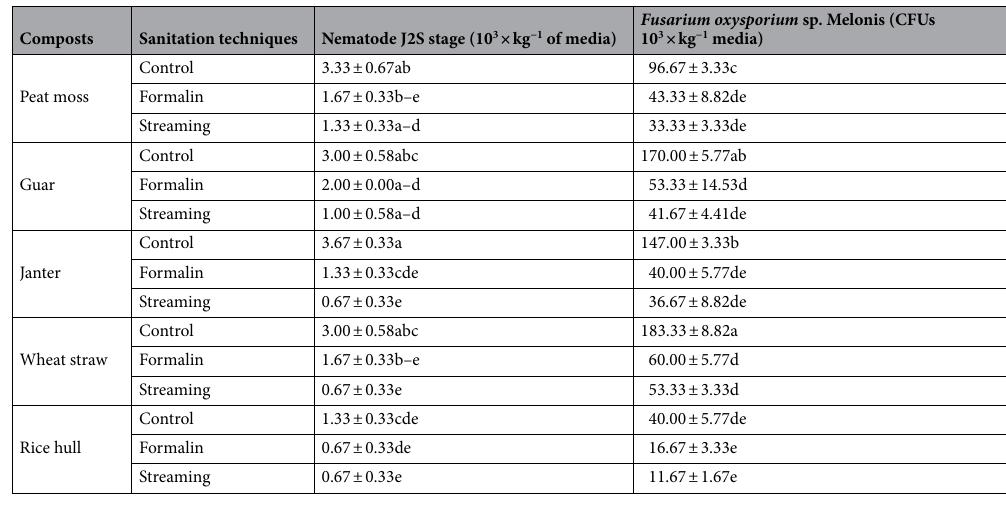
Table 3. Effect of composts and sanitation techniques on relative abundance of juveniles of root knot nematode and Fusarium oxysporium sp. melonis in the media. All the values are means of three replicates, whereas letters exhibit significant differences among the treatments at p ≤ 0.05